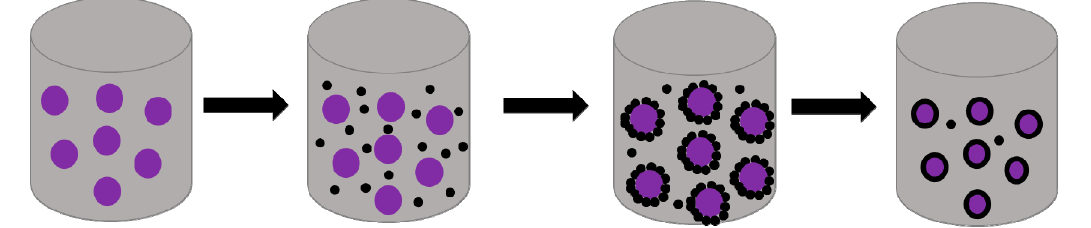
Figure 3. Microencapsulation with coacervation.